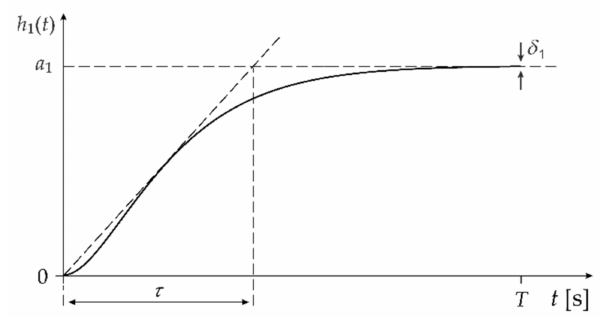
Figure 1. Step response of a first-order